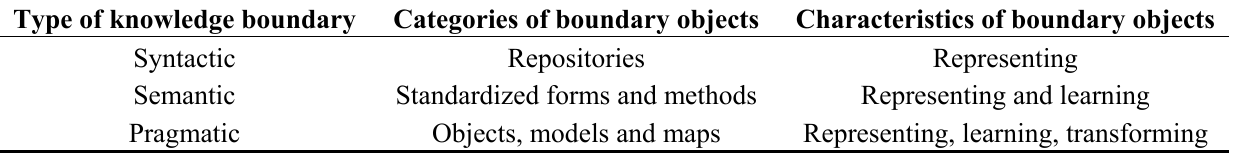
Table 2. Types of knowledge boundary, category, and characteristics of boundary objects